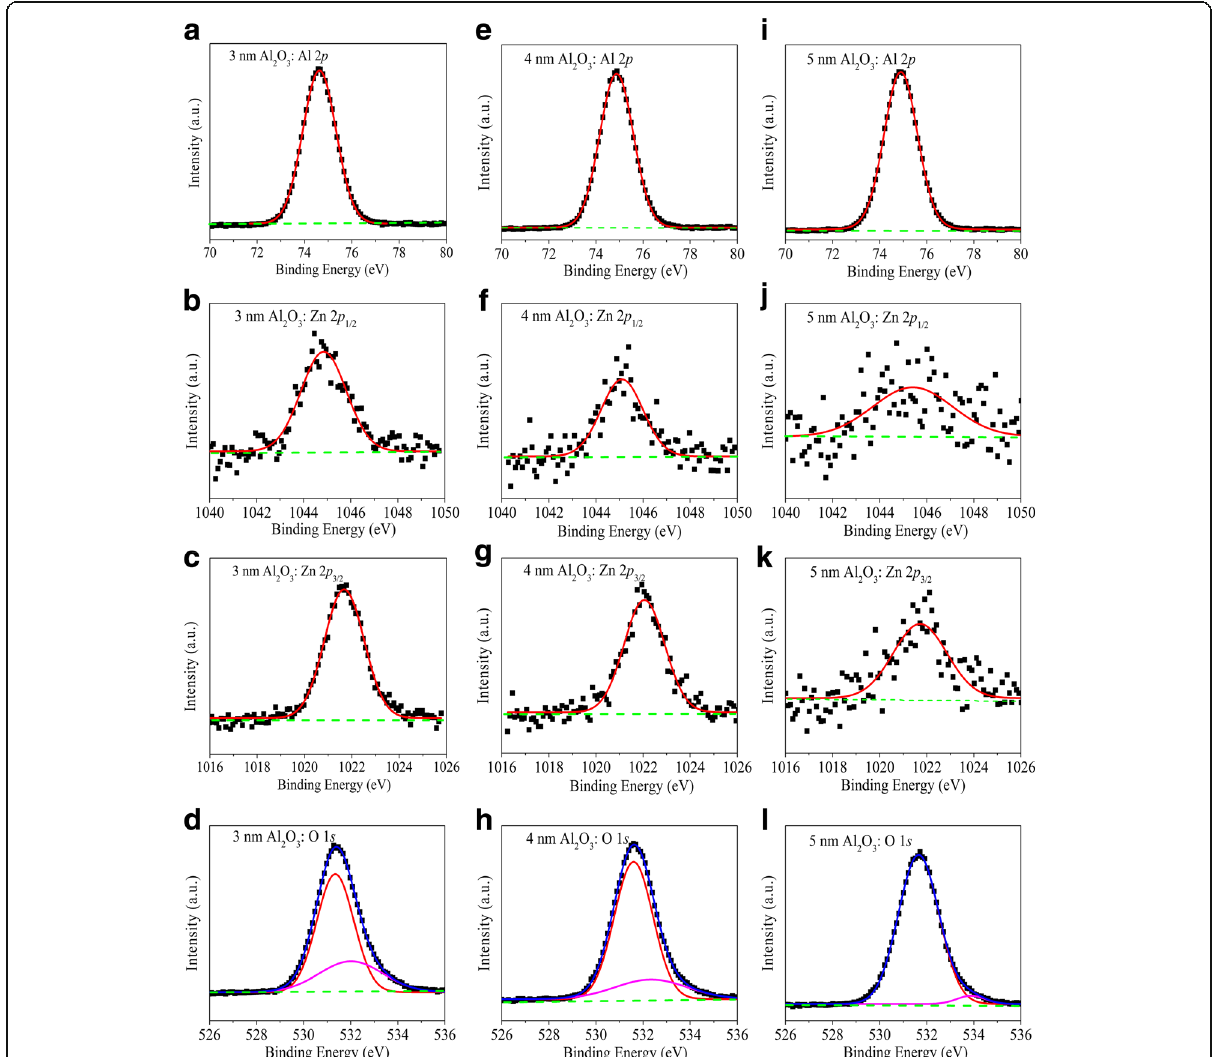
Fig. 4 CLs of Al 2 O 3 /Zn 0.8 Al 0.2 O samples with varied Al 2 O 3 thickness a – d 3 nm, e – h 4 nm, and i – l 5 nm, with application of a low-energy electron flood gun